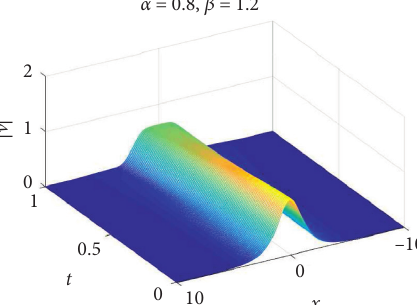
Figure 7: The trace of the solution to | v | of FCNLSE (32) with α � 0 . 6 and β � 1 . 8.